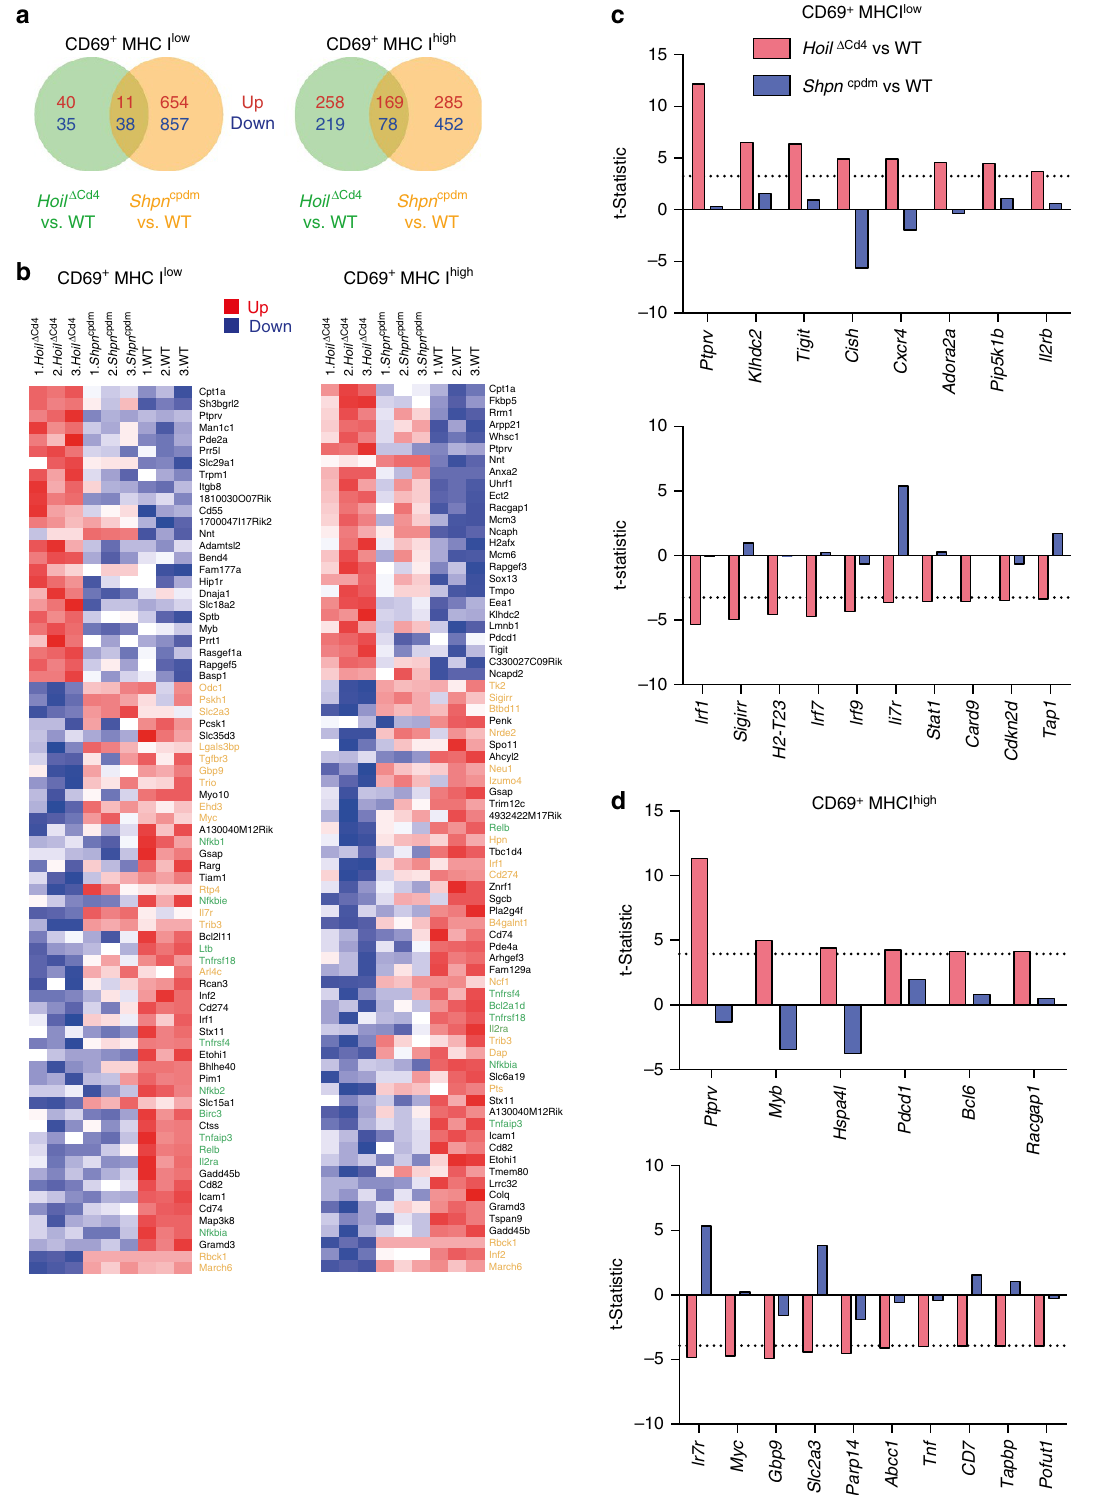
Figure 6 | Transcriptional impact of LUBAC deficiency on T-cell differentiation. ( a ) Venn diagrams of the numbers of genes upregulated (red) or downregulated (blue) in comparisons of CD69 þ MHC I low or CD69 þ MHC I high thymocytes from Hoil D Cd4 versus WT (green) and Sharpin cpdm versus WT (orange) at a 5% false discovery rate (FDR) cutoff. ( b ) Heatmaps of individual log-expression values. Left plot shows the 25 most upregulated genes and 50 most downregulated genes for Hoil D Cd4 versus WT in CD69 þ MHC I low thymocytes. Right plot show the same for CD69 þ MHC I high . Genes are ordered by P -value. Red indicates relatively higher expression and blue indicates relatively lower expression. Genes highlighted in green are involved in NF- k B signalling, those in yellow are involved in thymocyte/Treg cell differentiation. Shpn cpdm refers to Sharpin cpdm mice. ( c , d ) Genes that are differentially expressed in Hoil D Cd4 versus WT but show no change or opposite change in Sharpin cpdm . Results for CD69 þ MHC I low thymocytes are shown in c and CD69 þ MHC I high thymocytes in d . The plot shows the limma t -statistics for each gene for assessing differential expression; the dotted line indicates the 5% FDR cutoffs of t ¼ 3.25 for c and t ¼ 3.94 for d